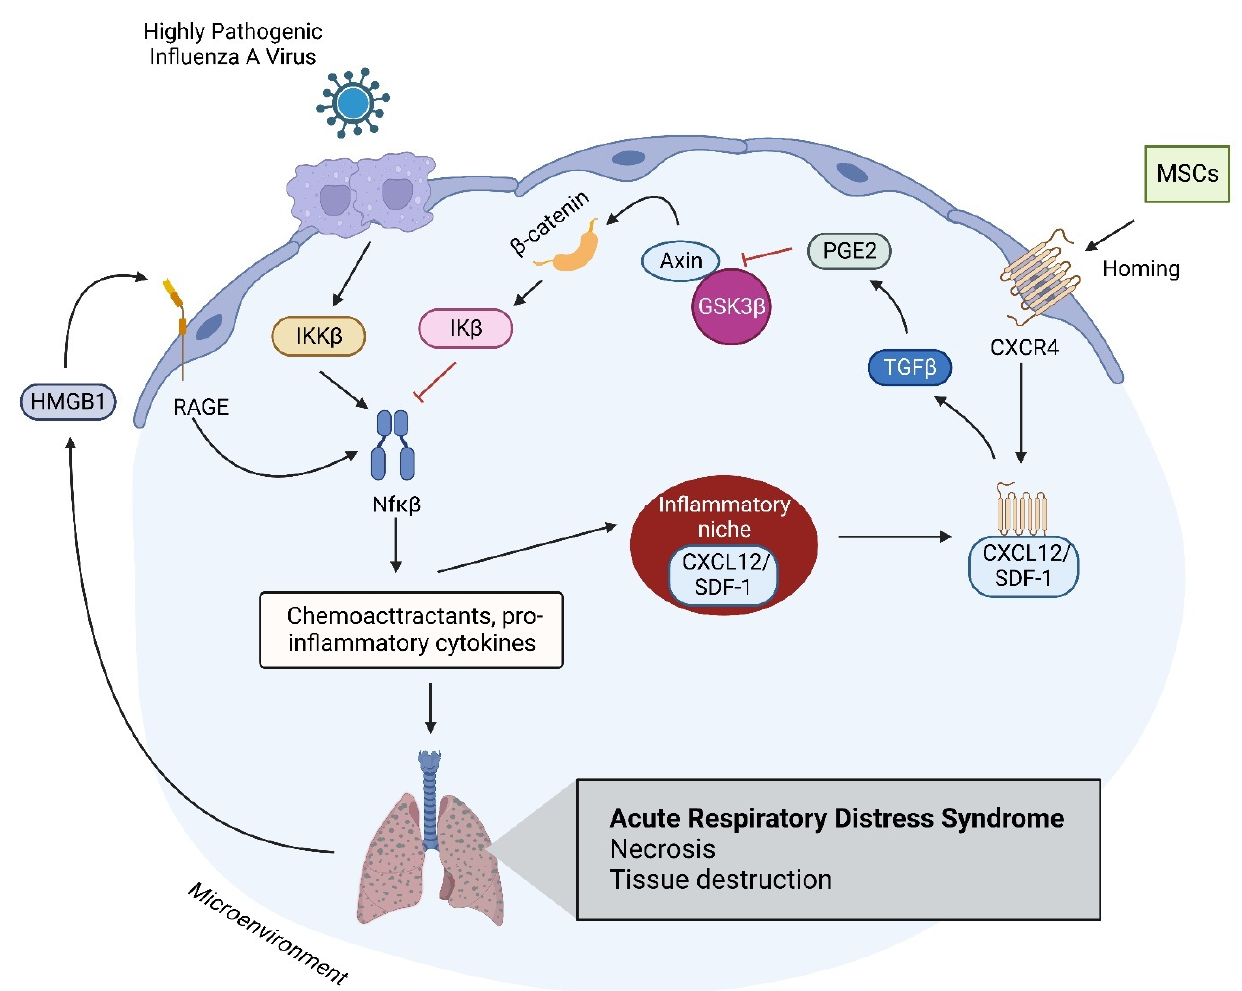
Figure 4. Immunoregulation Mechanisms of Exogenous MSCs on Virus-Induced Acute Lung Injury. A single-stranded RNA of the highly pathogenic influenza A virus binding with the host initiates several signaling transductions. IKK β is then activated, which can lead to the phosphorylation and degradation of I κβ , causing the active transcription factor NF- κ B to release. NF- κ B encodes pro-inflammatory cytokines and chemokine attractants, which lead to ARDS. The injured cells release HMGB1, which has a high affinity to RAGE ligands. HMGB1 bonds with RAGE, and this cues a signal to activate NF- κ B, which releases adhesion molecules and pro-inflammatory cytokines. CXCL12 (SDF-1) regulation increases in the inflammation niche due to pro-inflammatory cytokine stimulation. CXCL12 (SDF-1) interacts with its ligand CXCR4, which is expressed by exogenous MSCs and starts the homing process. Active biomolecules of endogenous PGE2 are then produced in large amounts, which leads to the phosphorylation of GSK-3 such that β -catenin accumulates in the cytoplasm. These accumulations inhibit NF- κ B via the activation of I κβ , and as a consequence, the release of pro-inflammatory cytokines and chemokines is inhibited. This figure was created using the BioRender online app and